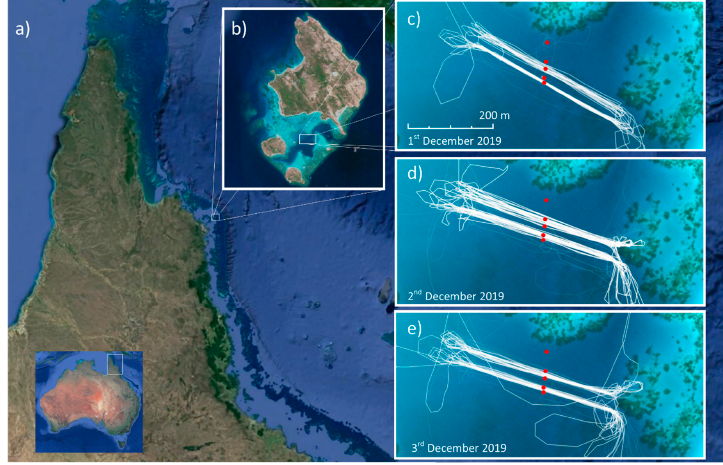
Figure 1. ( a ) Map of Australia with expansion of Cape York Peninsula, Queensland; ( b ) expansion of Lizard Island on the Great Barrier Reef; ( c – e ) expansions of the island lagoon with the vessel tracks from three consecutive survey days ( c , d , and e , respectively) displayed in white and the positions of pairs of seafloor-mounted SoundTraps shown by the red dots.